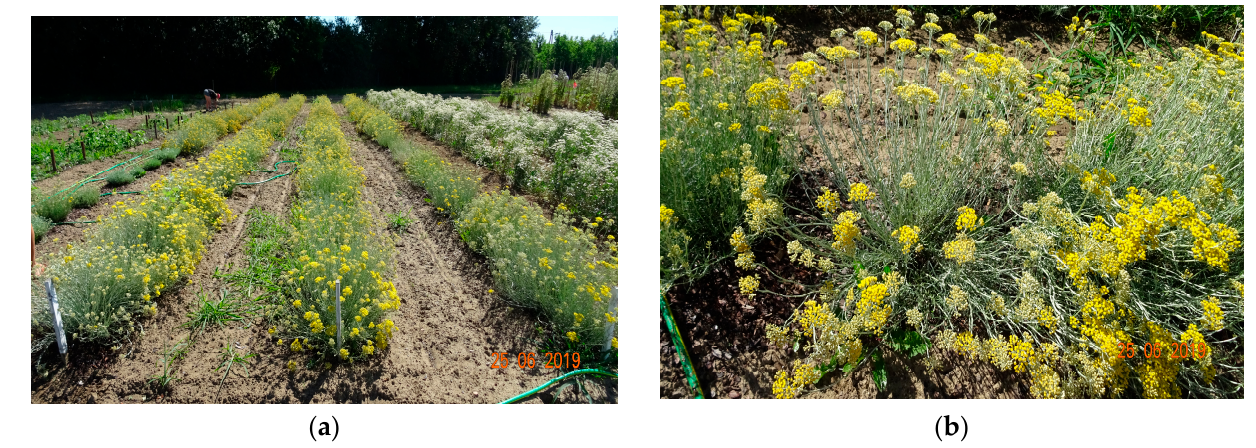
Figure 3. Field experiment overview ( a ) and flowering plants of H. italicum ( b ).